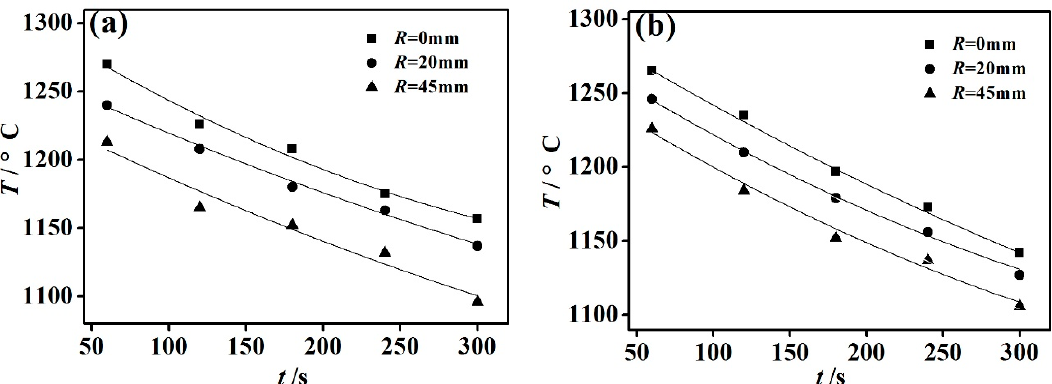
Figure 11. Temperature distribution in melt ( a ) without AMF and ( b ) with AMF.